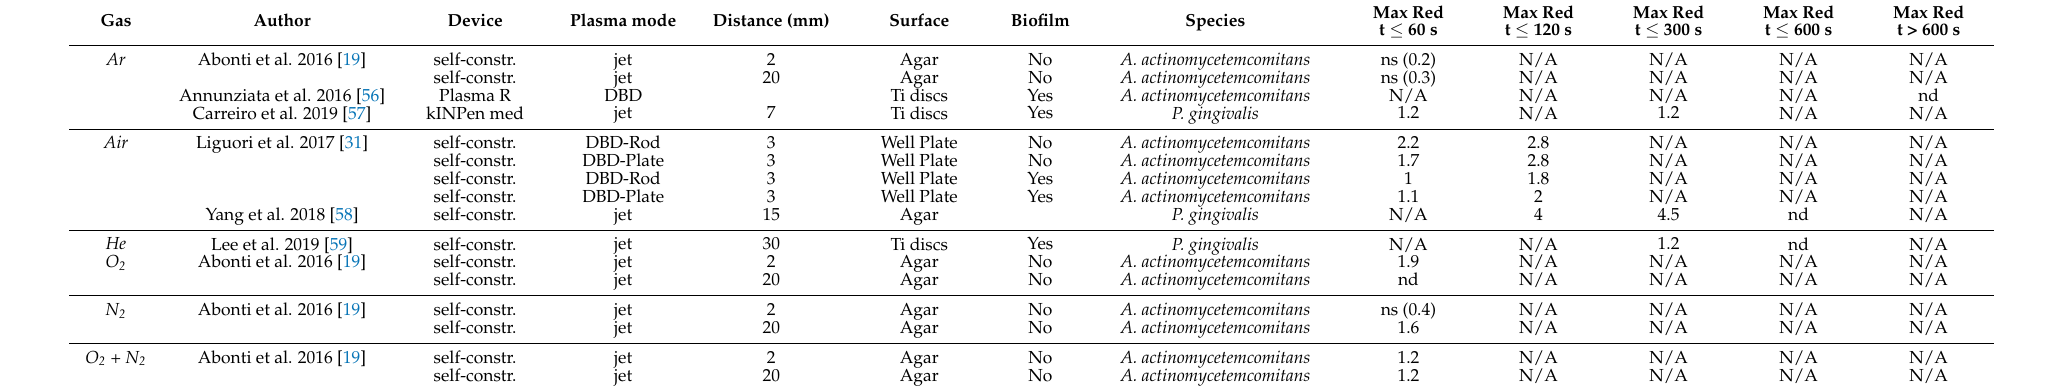
Table 4. Effect of CAP on bacteria associated with periodontal disease; Abbreviations: conc.: concentration; DBD: dielectric barrier discharge; max red: maximal reduction; N/A: not available; nd: non-detectable; ns: non-significant; self-constr.: self-constructed; Ti: